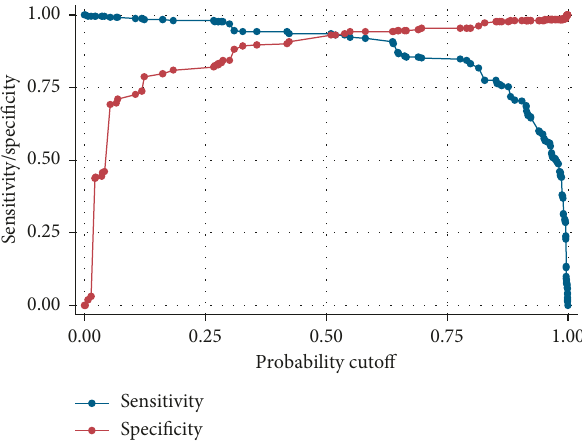
Figure 2: Sensitivity and specificity of SAM predictive score.